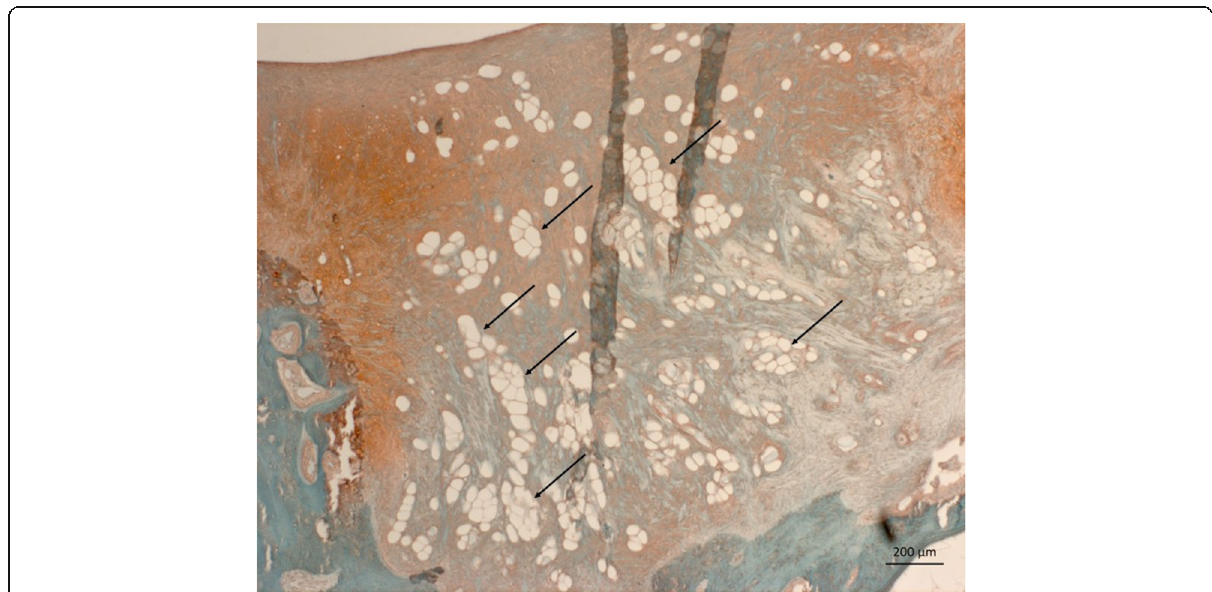
Fig. 6 Safranin O staining; scale bar 200 μ m. Magnification 50-fold. Infiltration of marrow (arrows), seen as fat, into a CB treated defect